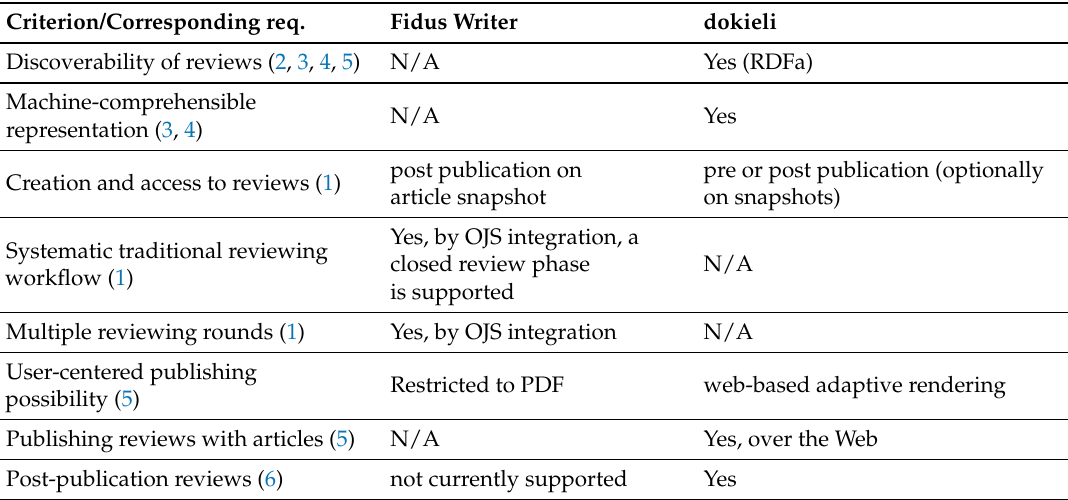
Table 1. Strengths of the selected components w.r.t. our